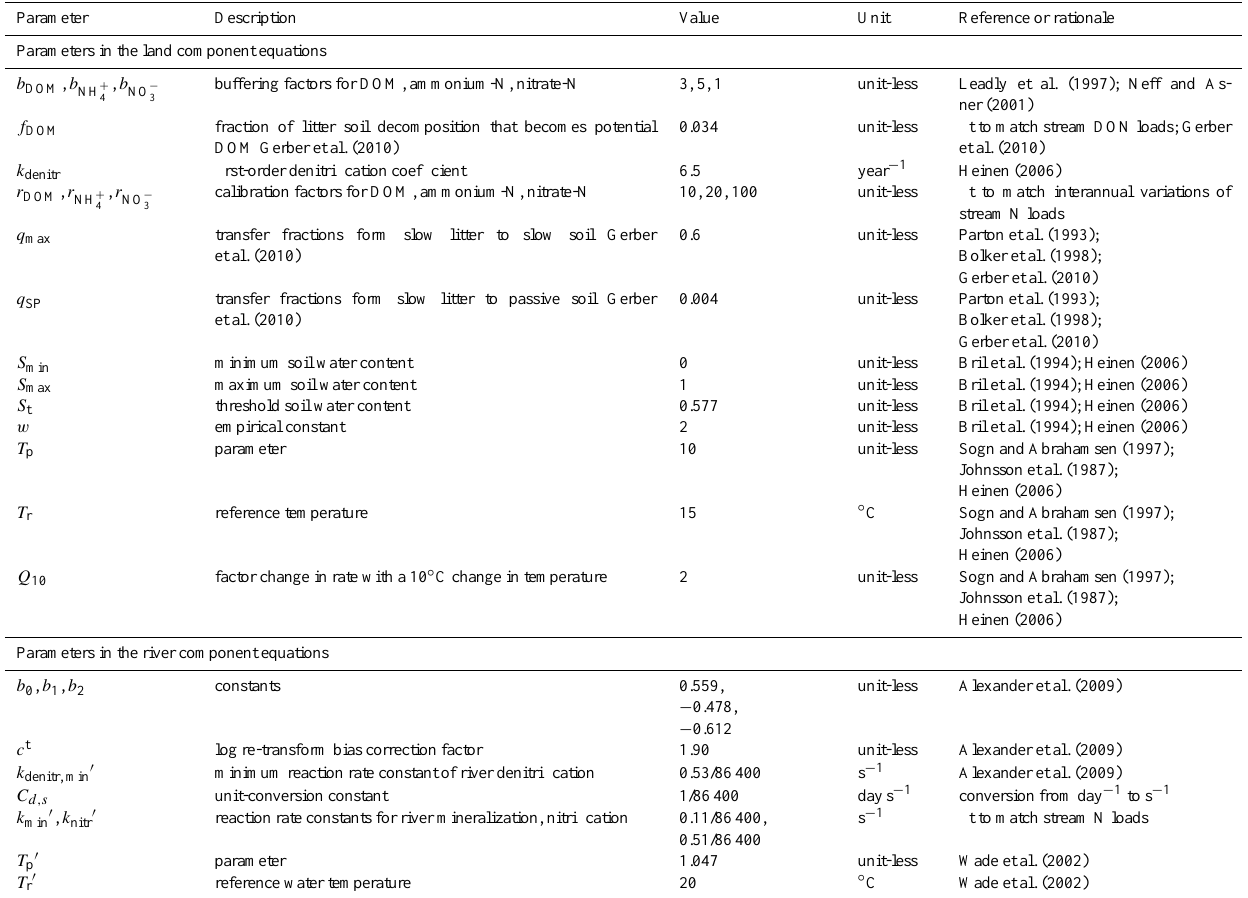
Table 1. Newly introduced or adjusted parameters from the earlier developments.